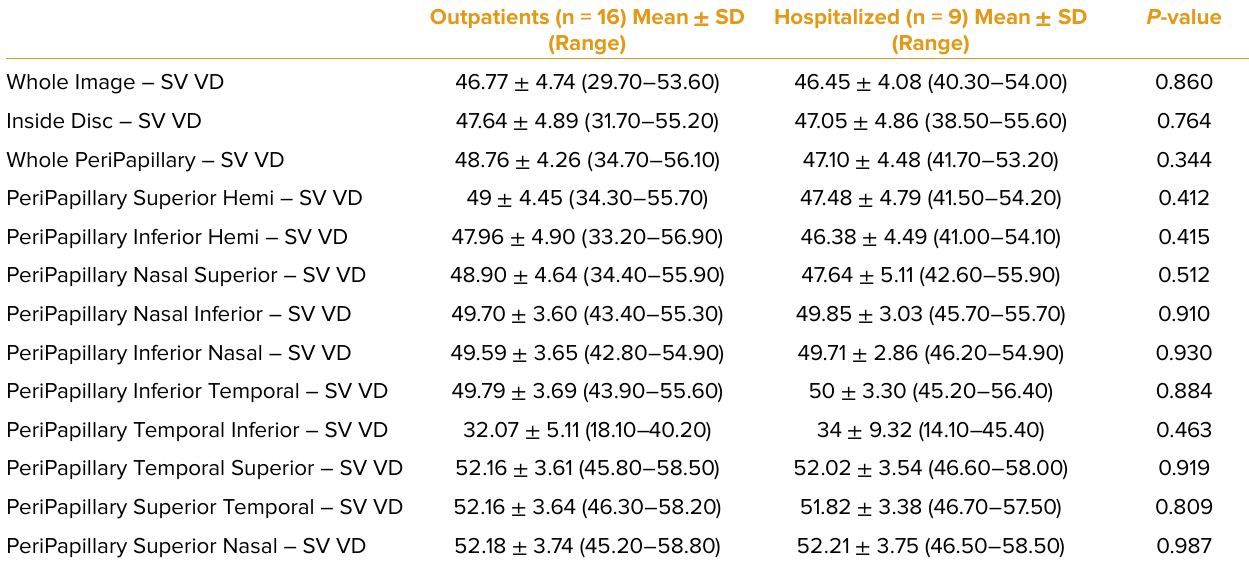
Table 4. Comparison of small vessels (SV) vessel density (VD) of hospitalized versus non-hospitalized/outpatients treated COVID-19